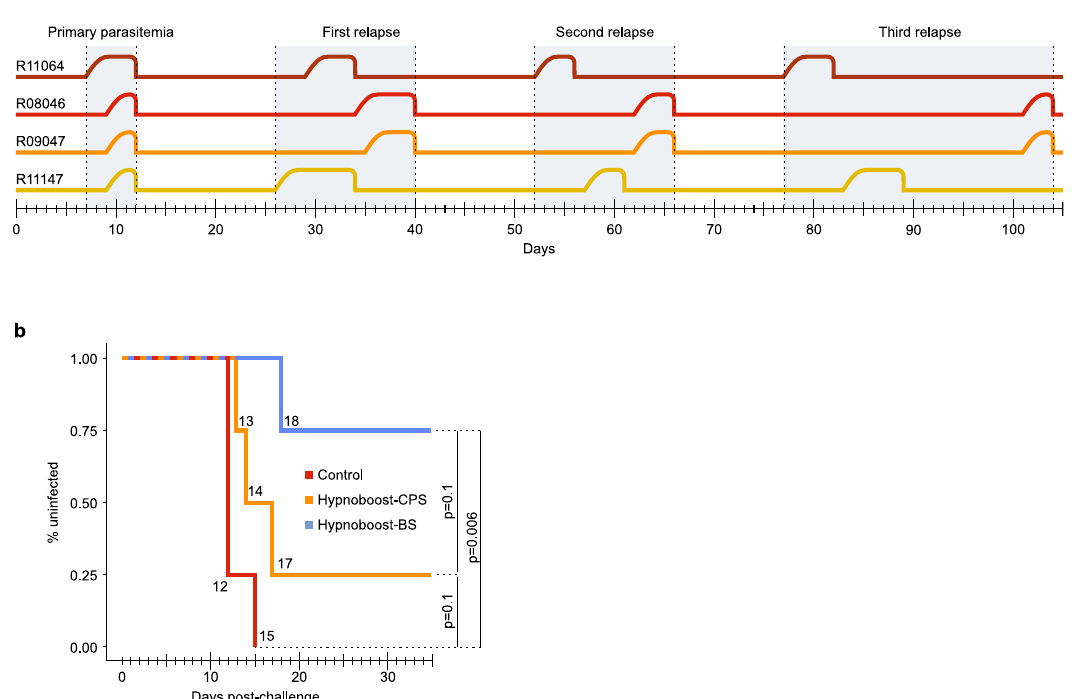
Fig. 2 Relapse patterns and challenge outcome. a Primary parasitemia and relapse patterns of the four monkeys in the hypnoboost-BS group as monitored by daily blood smears, in days post vaccination. b Day to patency post P. cynomolgi sporozoite challenge of animals in the control group (red line), the hypnoboost-CPS group (orange line) and the hypnoboost-BS group (blue line). In total four of eight vaccinated animals were sterily protected. p -values are given for the inter-group comparison computed using R (survival package; log-rank